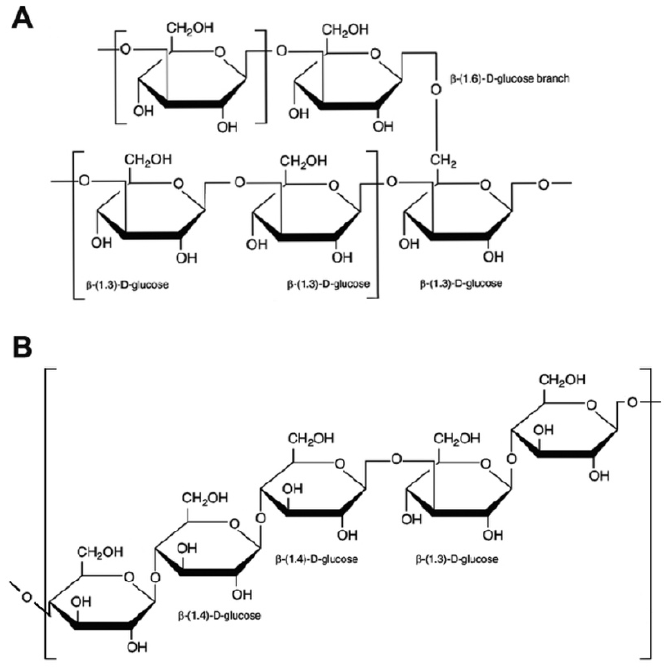
Figure 1. Chemical structures of β -glucans. The side branches of mushroom β -glucans ( A ) are at- attached to the β -1,3-D-glucan main chain by a β -1,6 linkage, and may consist of one or several tached to the β -1,3-D- glucan main chain by a β - 1,6 linkage, and may consist of one or several β -D- β -D-glucose units; cereal β -glucans ( B ) are linear and consist of D-glucose molecules linked by 1,3 β - glucose units; cereal β -glucans ( B ) are linear and consist of D- glucose molecules linked by 1,3 β - and and 1,4 β - 1,4 β - linkages.